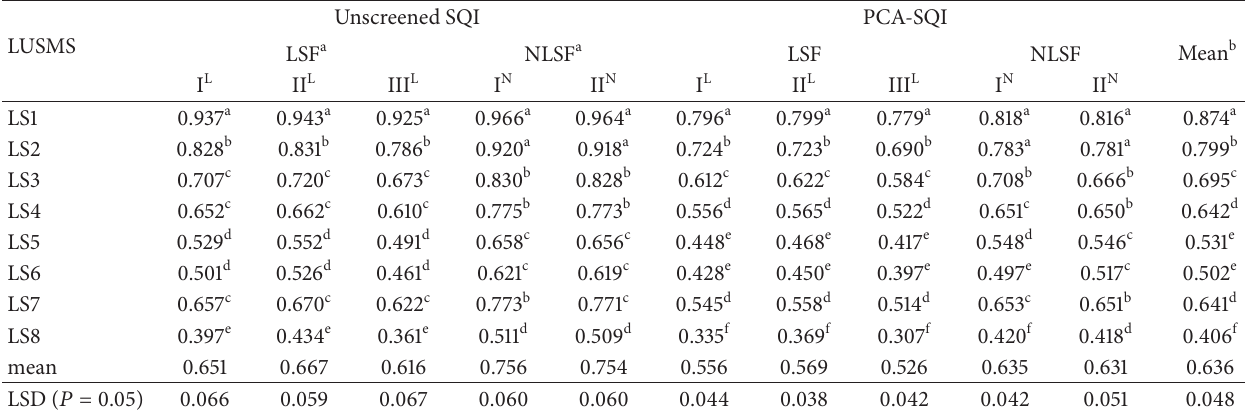
Table 6: Soil quality indices developed using an EO selected dataset to compare eight LUSMS in the Mai-Negus catchment of northern Ethiopia.